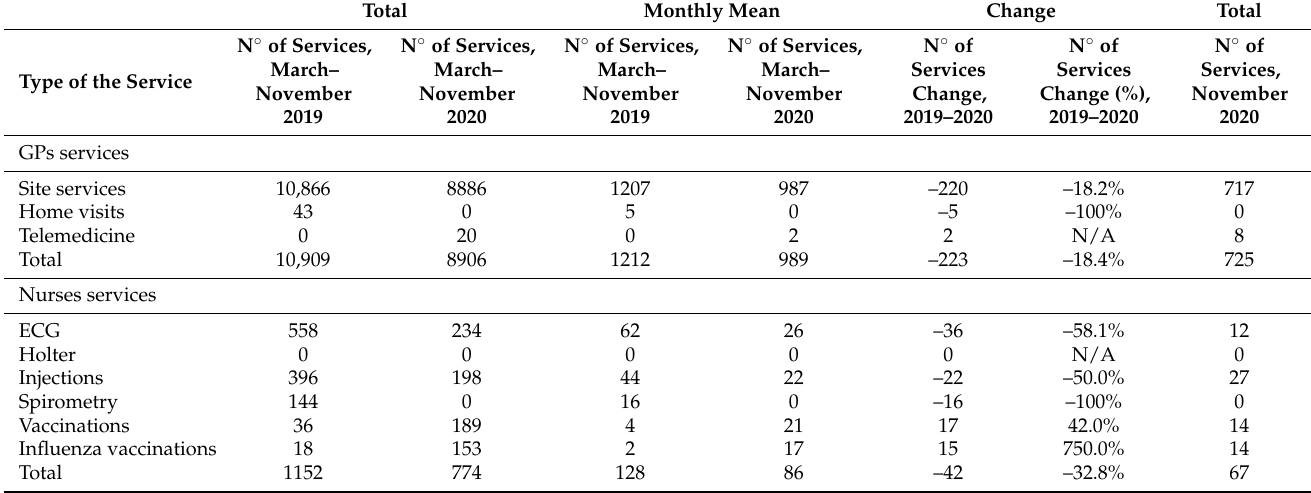
Table 10. Number of services provided by GPs and nurses to the patients of Clinic 4 in March–November 2019